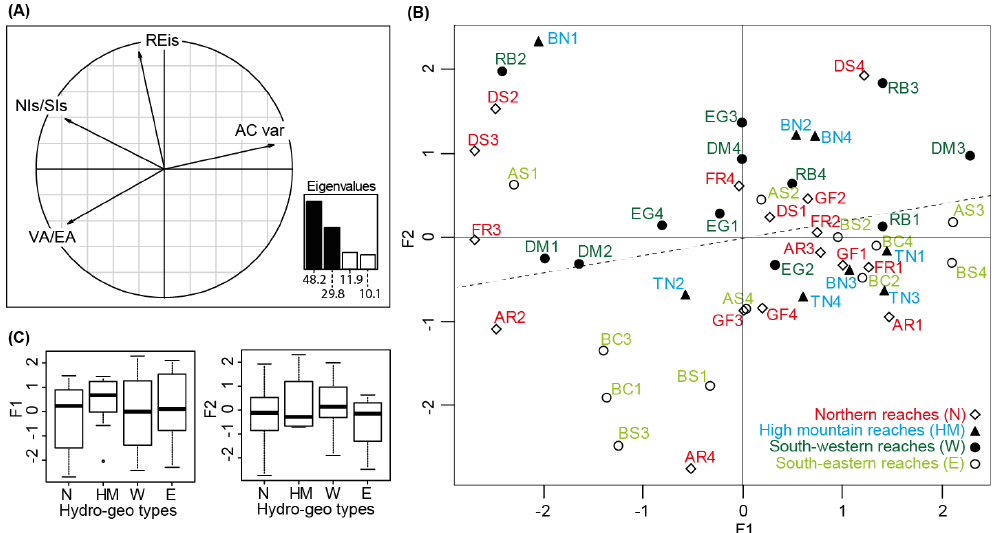
Fig. 4. Results of the Principal Component Analysis performed on the landscape variables, to simplify the large dataset. Landscape variable acronyms are listed in Table 2. (A) The correlation circle and the histogram with eigenvalues show, respectively, how landscape variables are related with the two first components of the PCA, and the variance between reaches explained by each component of the PCA (78% is the cumulative variance explained by the first two components). The first component is related with ACvar (rho = 0.9, p value <0.0001), the NIs/SIs (rho = − 0.74, p value <0.0001) and the VA/EA (rho = -0.81, p value <0.0001); the second component is related with REis (rho = 0.9, p values <0.0001) and with the NIs/SIs (rho = 0.33, p value 0.02) and the VA/EA (rho = − 0.35, p value = 0.01). (B) The first factorial map displays how each reach is positioned in regard to the first two components; each item is a reach at a given observation date (i.e. reach1, reach2, reach3 and reach4). Reaches have been plotted following hydro-geographical regions. The dotted line is perpendicular to island residual vector, and divides positive from negative residuals. (C) The variability of the first two component coordinates, obtained for each reach, among hydro-geographical types (N, northern reaches; HM, high mountain reaches; W, south-western reaches; E, south-eastern